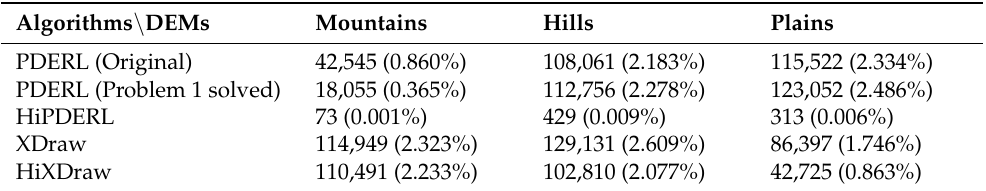
Table 1. Total error number and error rate on different DEMs with different algorithms (Total cell number: 49,490,000).